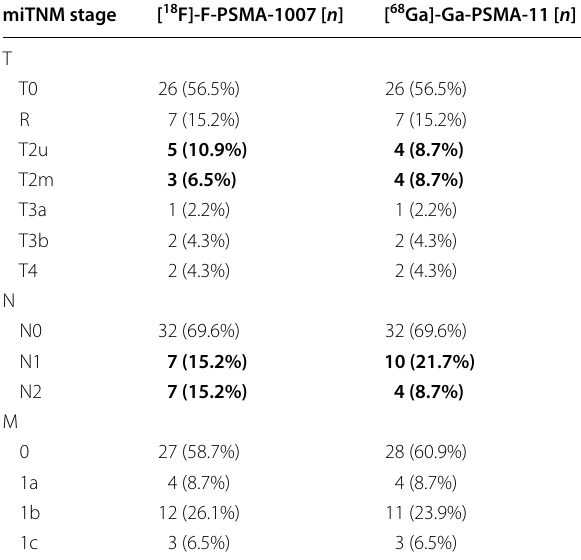
Table 2 miTNM stages by tracer